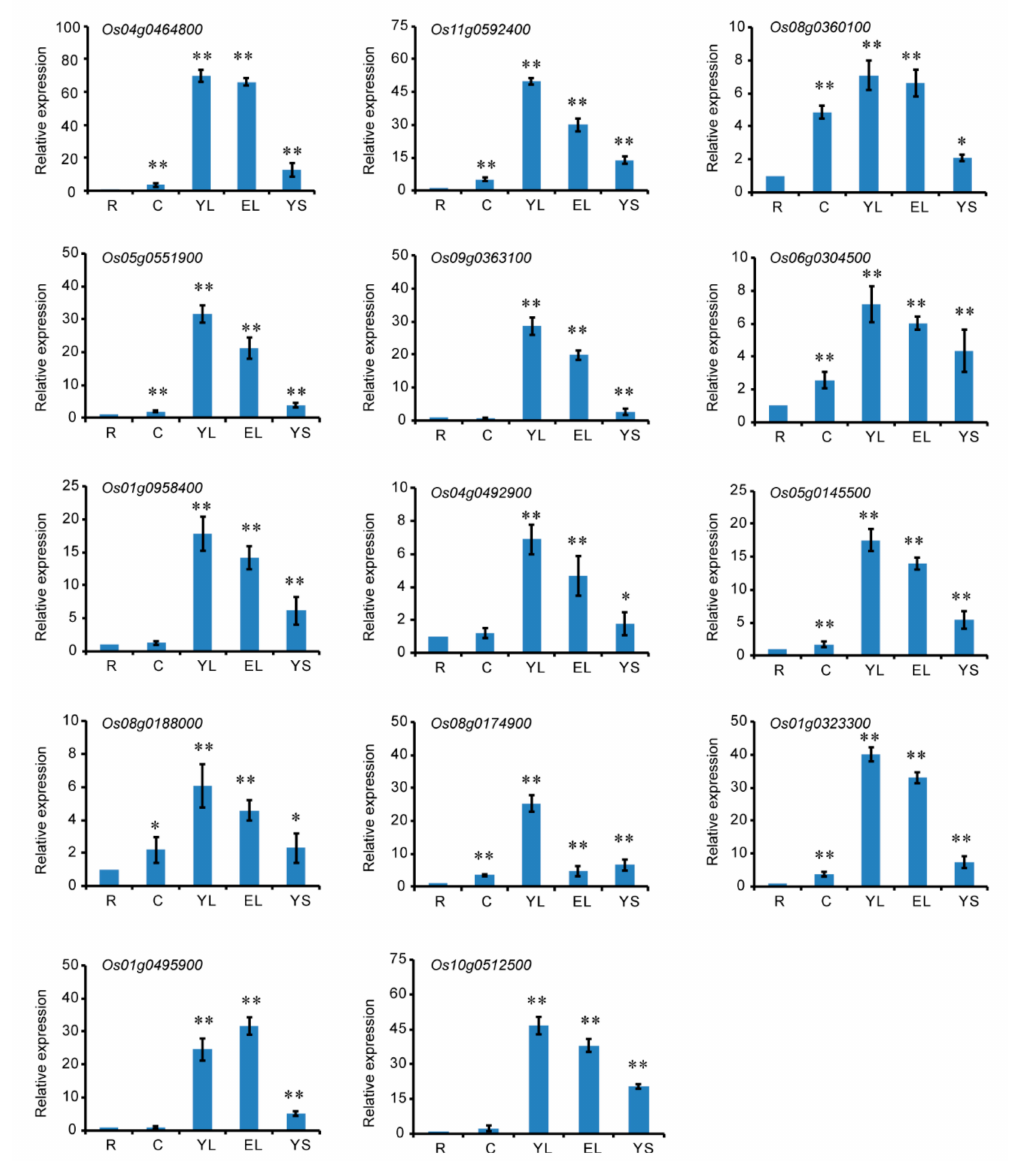
Figure 4. Analysis of CRM gene expression in various rice tissues by qRT-PCR. Tissues, including root (R), culm (C), young leaf, expansion leaf (EL), and young spikelet (YS), at the booting stage. The relative expression level in each tissue was controlled by the gene expression level in the root. Data are the mean ± SD for three biological replicates. * p < 0.05, ** p < 0.01 by Student’s